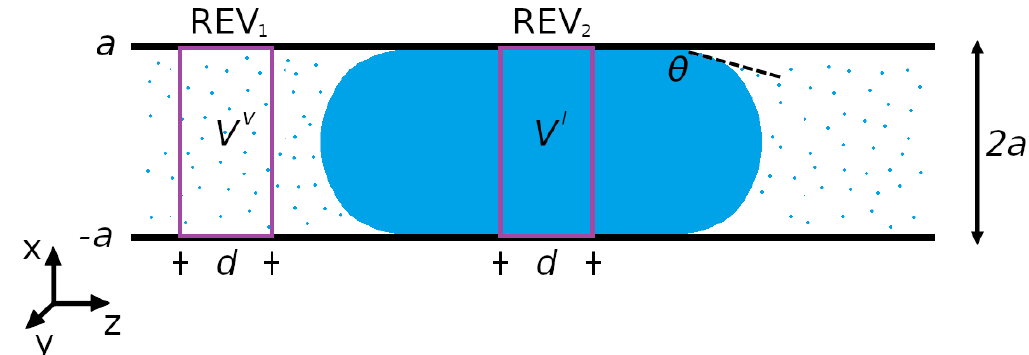
Figure 1. Slit pore of width 2 a with a liquid droplet in the middle, which is in equilibrium with a vapor phase on both sides. The representative volume elements are REV 1 (vapor of volume V v ) and REV 2 (liquid of volume V l ), both with length d . The x -axis is located at the center of the